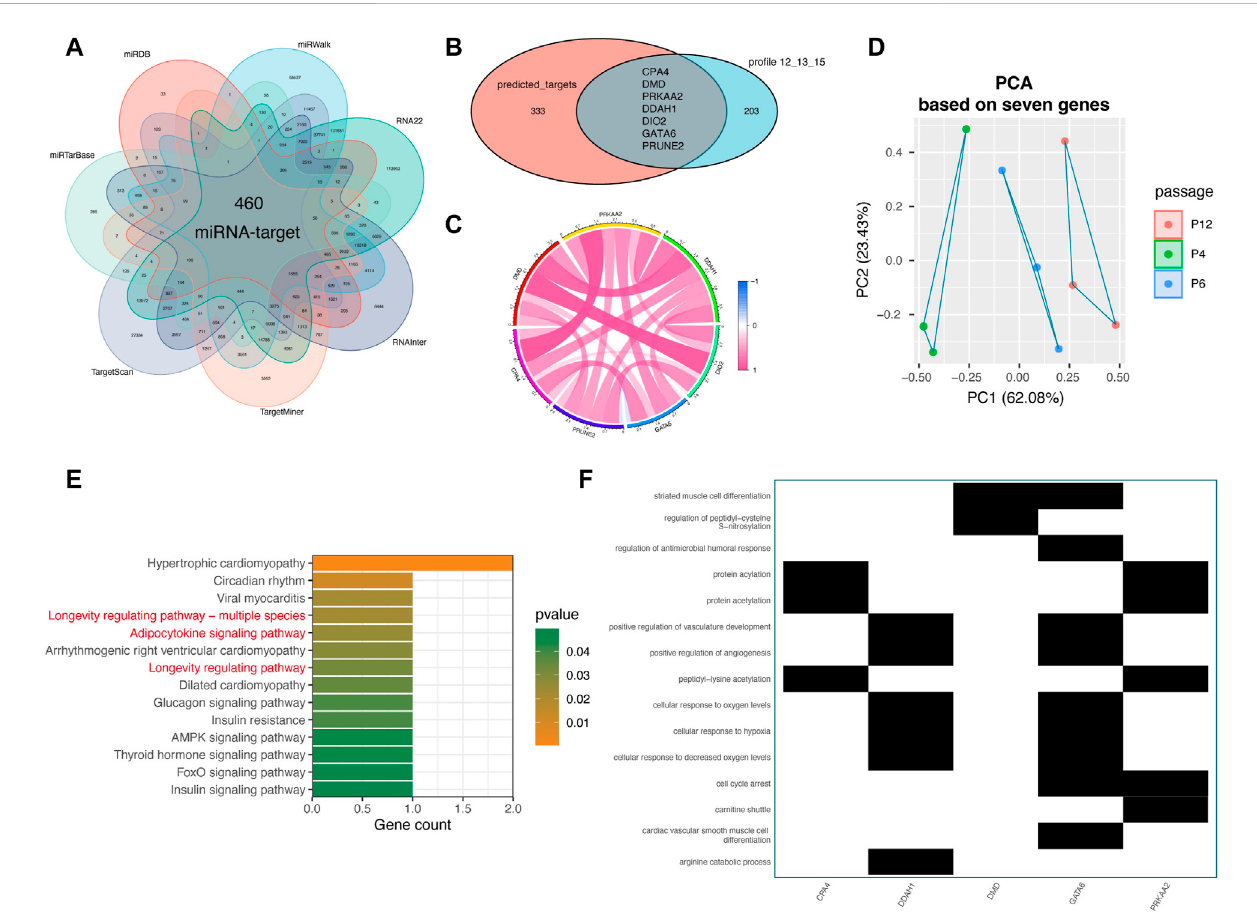
FIGURE 3 Target prediction analysis for 29 miRNAs and function analysis of key targets. (A) Intersection analysis of potential targets from seven miRNA target prediction databases for 29 miRNAs, including TargetScan (http://www.targets.can.org/vert._72/), miRTarBase (http://mirtarbase.mbc.nctu.edu.tw/php/ index.php), miRDB (http://www.mirdb.org/), miRWalk (http://mirwalk.umm.uni-heidelberg.de/), RNA22 (https://cm.jefferson.edu/rna22/), RNAinter (http:// www.rnainter.org/), TargetMiner (https://www.isical.ac.in/). (B) Intersection analysis of prediction targets and the 210 passage-speci fi c mRNAs from mRNA Pro fi le 12. (C) Correlation analysis among seven miRNA targets, containing CPA4, DMD, PRKAA2, DDAH1, DIO2, GATA6, and PRUNE2. (D) PCA analysis of MSCs based on seven target genes. “ PCA ” represents principal component analysis. (E) KEGG analysis of seven target genes. The top notable terms are displayed. (F) GO analysis of seven target